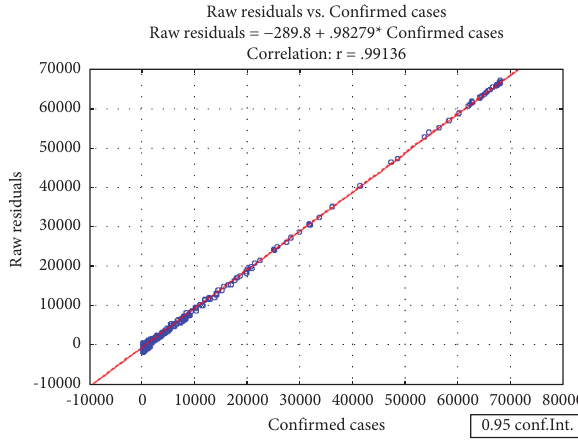
Figure 8: Raw residuals vs confirmed COVID-19 cases.